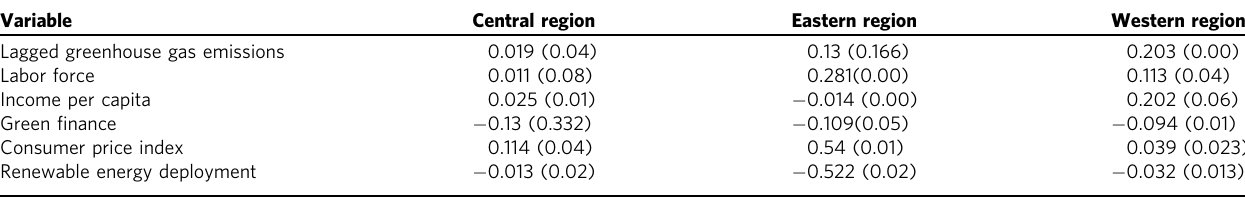
Table 6 Robustness check.